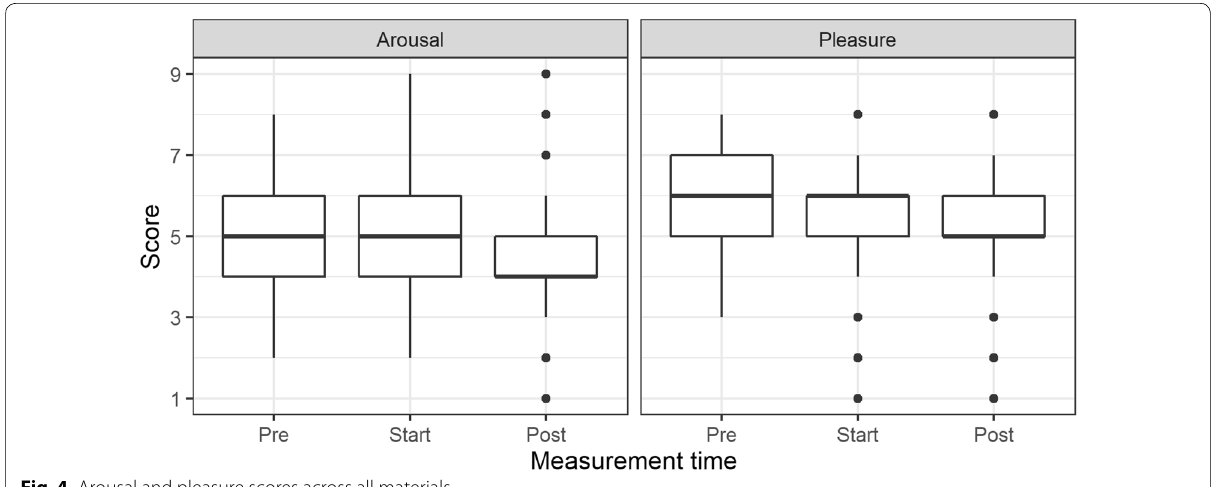
Fig. 4 Arousal and pleasure scores across all materials